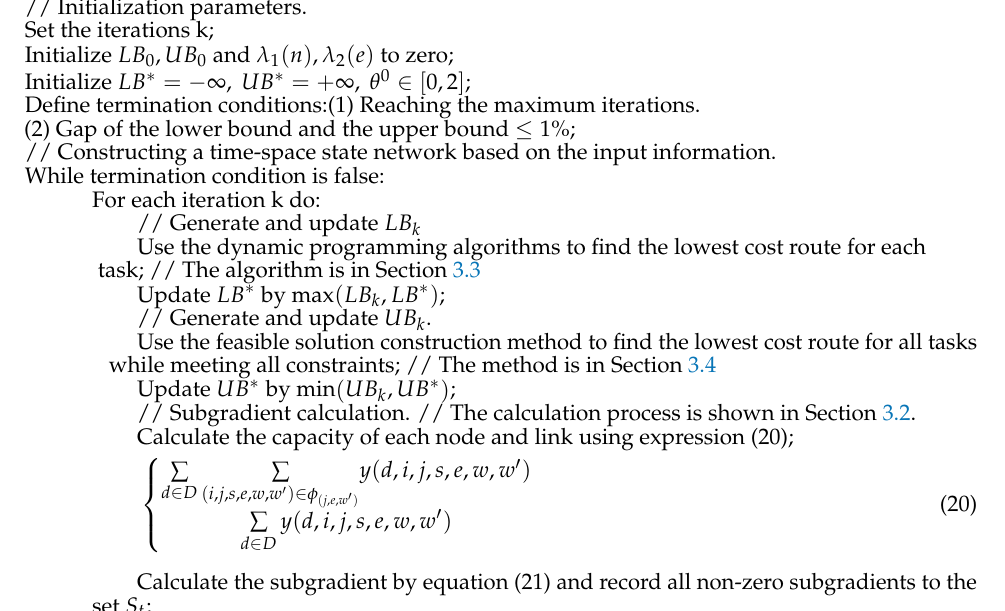
Algorithm 1. Lagrangian relaxation-based solution